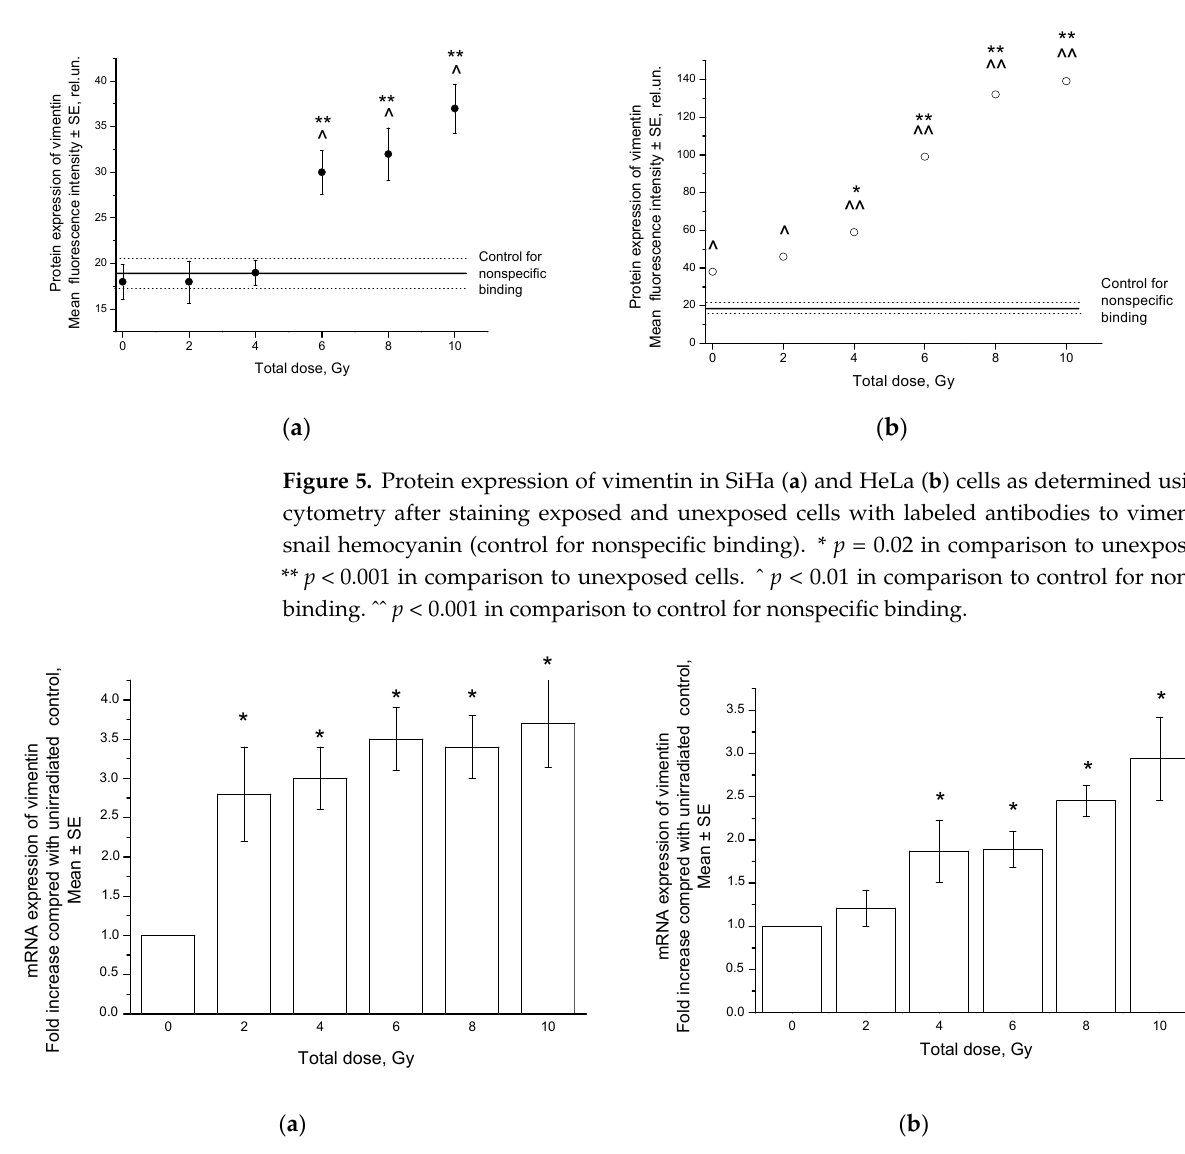
Figure 6. Vimentin mRNA expression in SiHa cells 24 h ( a ) and 8 days ( b ) after fractionated radiation exposure. * p < 0.01 in comparison to unexposed cells.